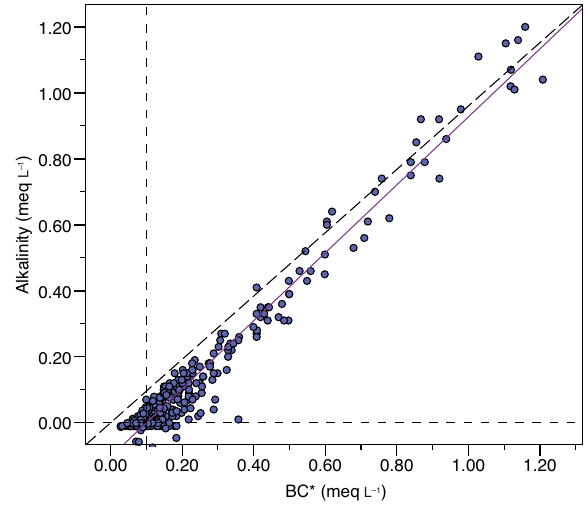
Fig. 9. An average deficit of alkalinity of approximately 0.1meqL − 1 was found before liming of the stream